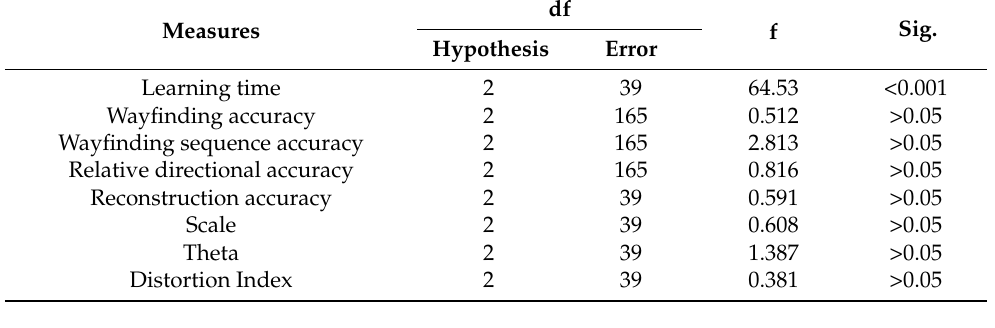
Table 5. Mean and standard deviation for tested measures as a function of learning-mode condi- Table 6. ANOVA results for each of the dependent tested measures as a function of learning-mode conditions. tions.